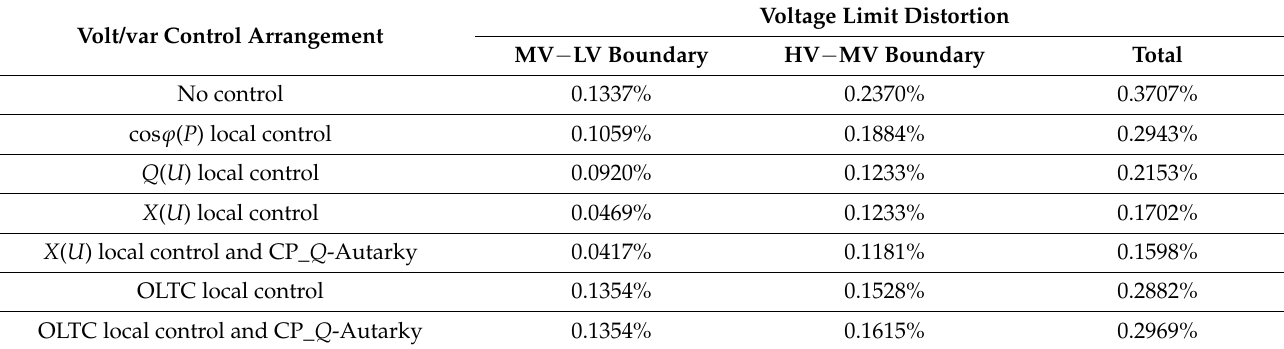
Figure 23. Voltage limit distortion for various control arrangements. Table 3. Voltage limit distortion for various control arrangements.